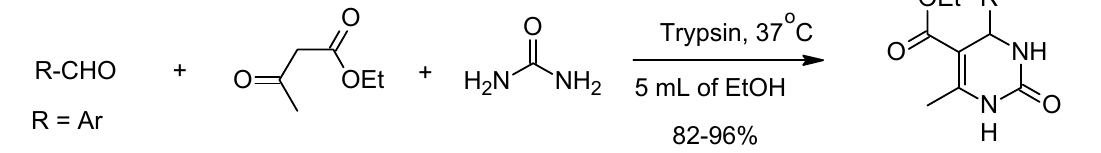
Scheme 4. Preparation of different dihydropyrimidinones via the enzyme-catalyzed Biginelli